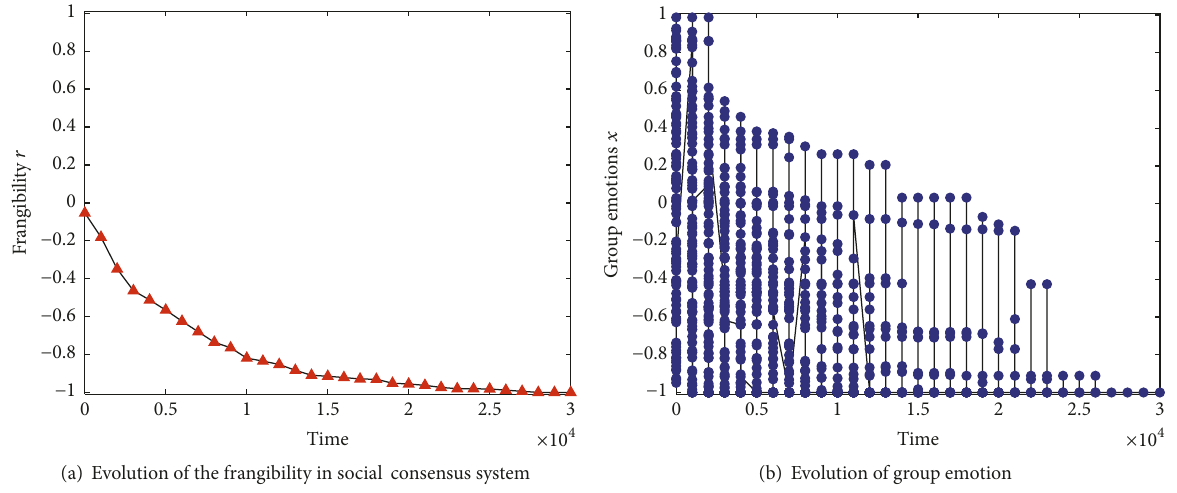
Figure 2: Evolution of social consensus system with low negative event